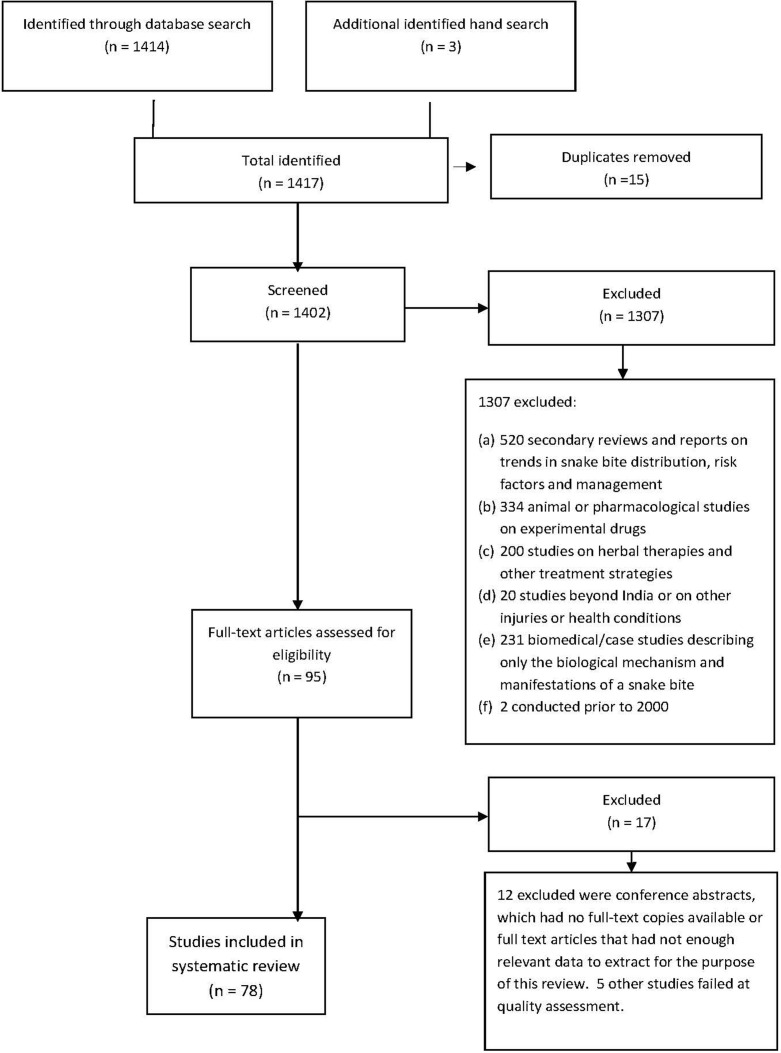
Study selection, inclusion and exclusion details.